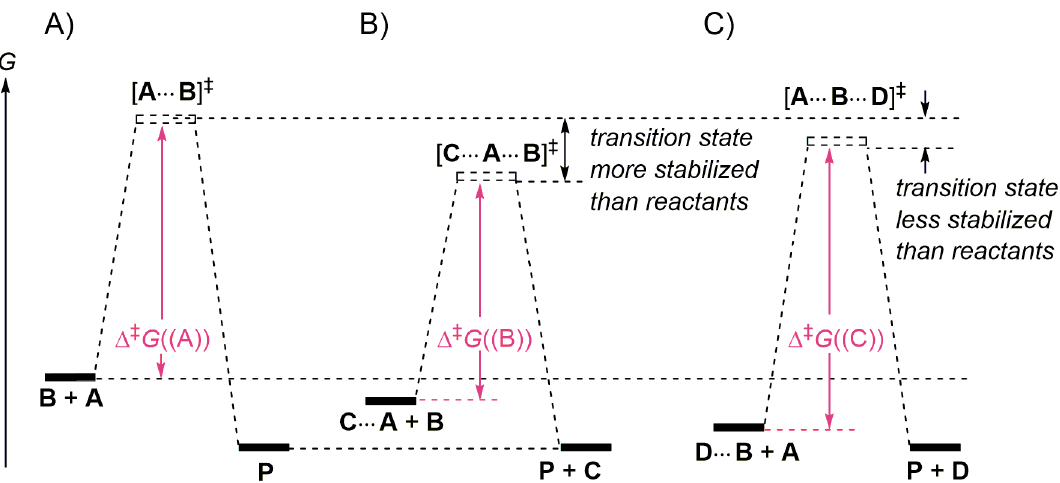
Figure 1. ( A ) Free energy diagram for an uncatalyzed gas phase bimolecular reaction converting A + B → P ; ( B ) free energy diagram for a catalyzed (catalyst C ) bimolecular reaction; ( C ) free energy diagram for a bimolecular reaction inhibited by additive D . If D is in substoichiometric concentration, the uncatalyzed reaction ( A ) will compete with ( C ). The retardation effect of D increases with its concentration.